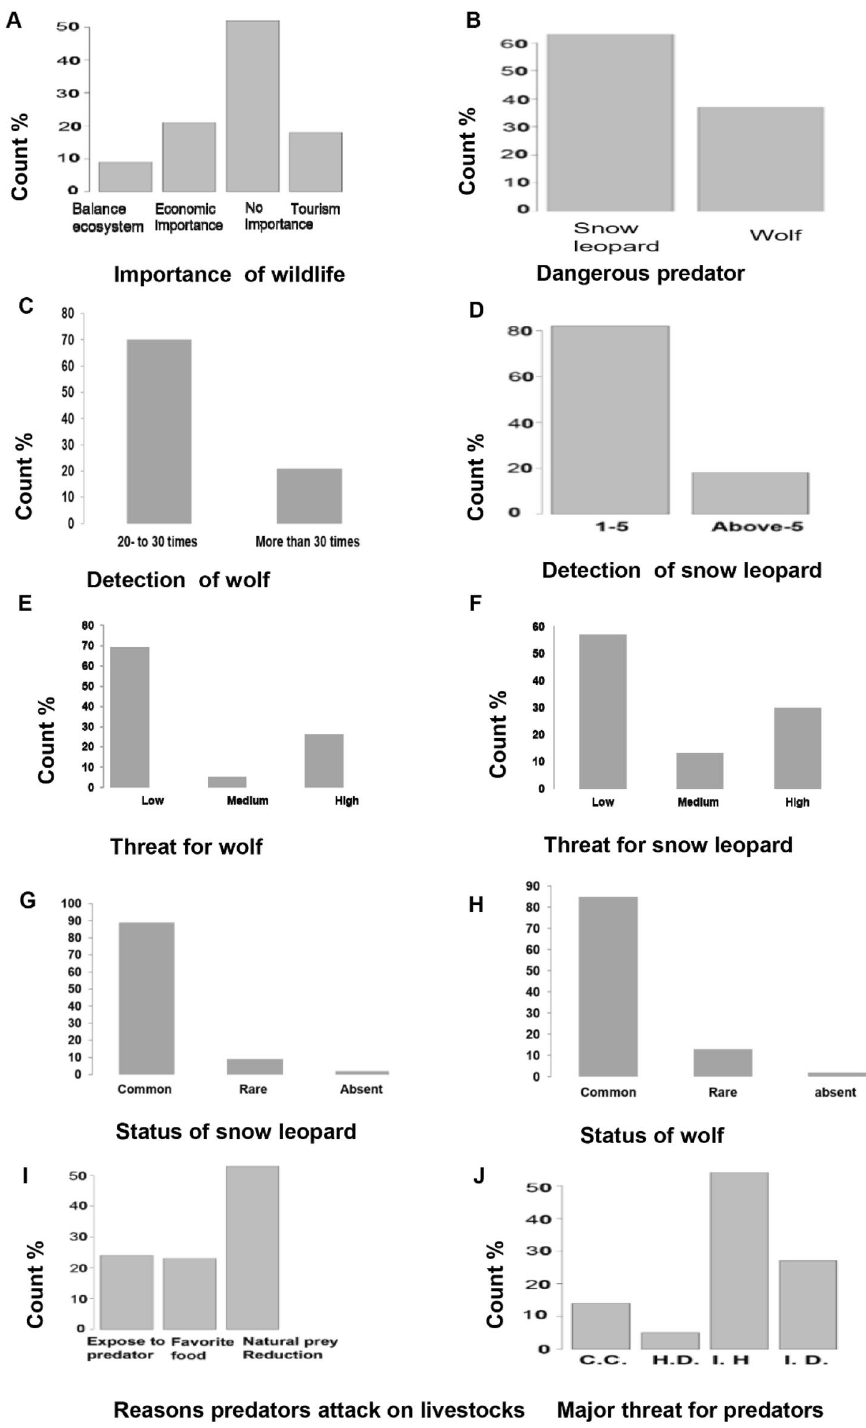
Figure 4. Circumstances of predation and perception of local community towards predators at Misger Valley. Major threats to wildlife (J) were categorized into climate change (CC), habitat destruction (HD), illegal hunting (IH), illegal hunting and habitat degradation